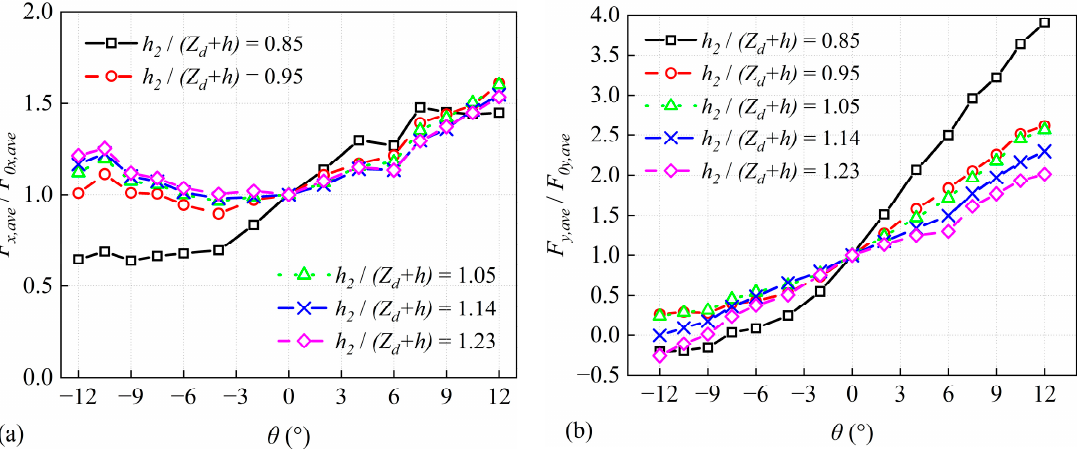
Figure 17. Relative average tsunami force when ( a ) horizontal and ( b ) vertical during the fl ow- around stage ( h 0 = 0.1 m, Z d = 0.2